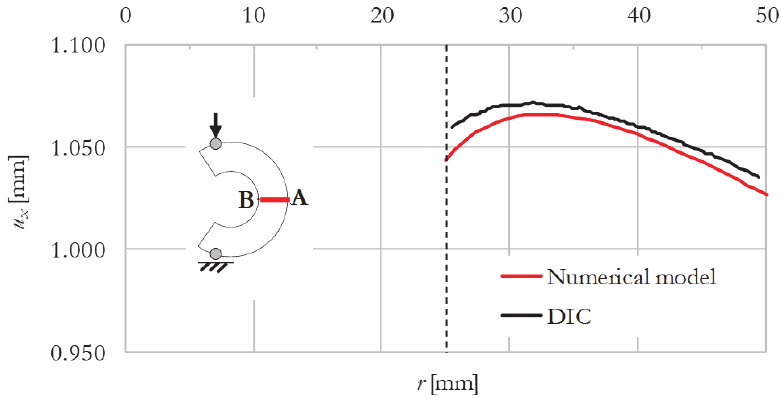
Figure 9: The horizontal component of the displacement field u x ≡ u developed along the AB locus determined numerically in juxtapo- sition to the respective one experimentally measured using the DIC technique